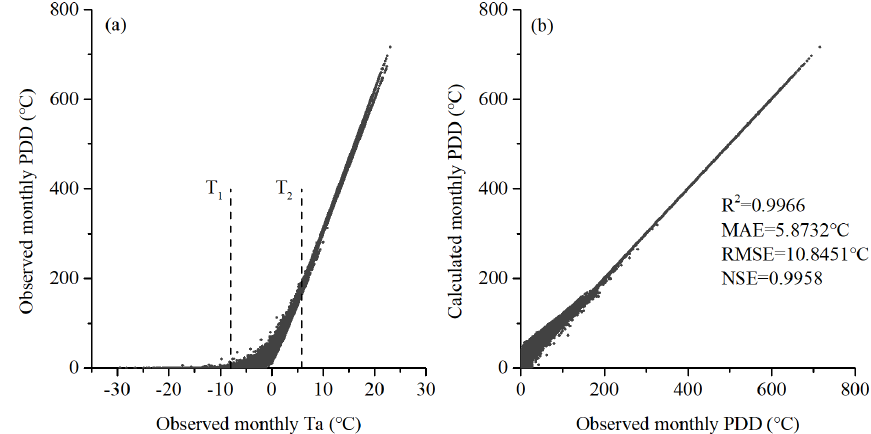
Figure 2. The relationship between the observed monthly accumulated positive air temperature (PDD) and mean air temperature ( T a ) (a) and the scatterplot between the calculated and observed monthly PDD (b) at meteorological stations in the mountain plateau zone of China. R 2 is the coefficient of determination, MAE is the mean absolute error (degrees Celsius), RMSE is the root mean square error (degrees Celsius) and NSE is the Nash–Sutcliffe